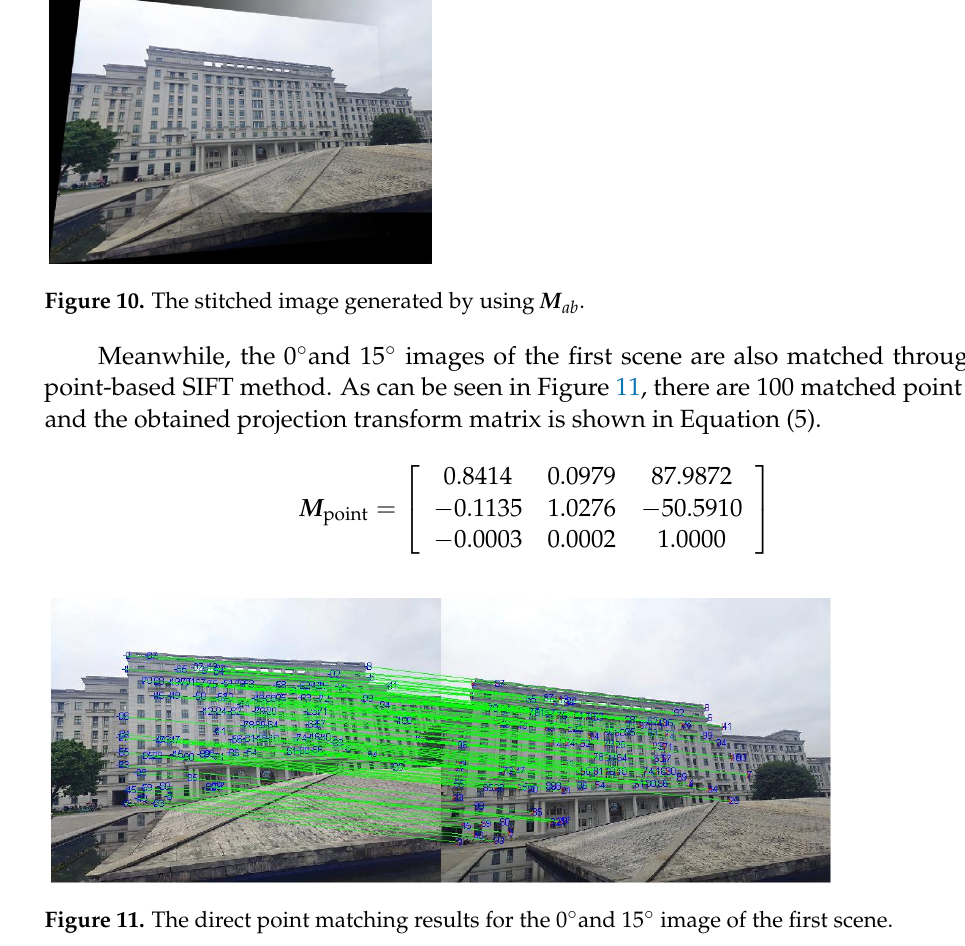
Figure 11. The direct point matching results for the 0°and 15° image of the first scene.